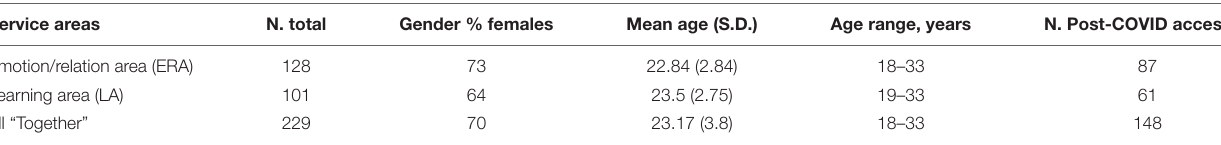
TABLE 1 | Sample description ( N =